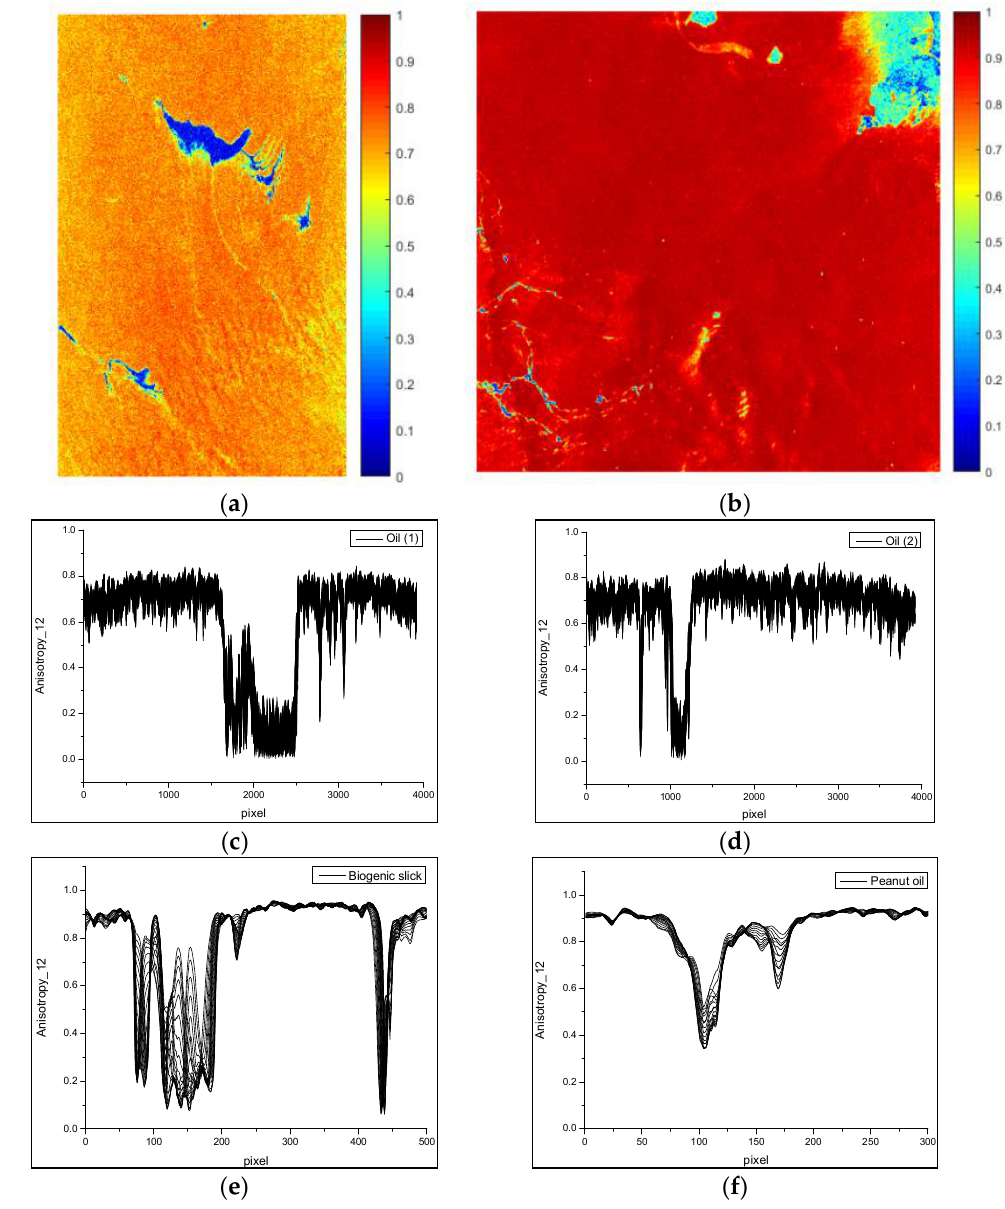
Figure 7. Modified anisotropy ( A 12 ) value for the two continuously slow-release slicks cases mentioned above: ( a ) Case 1; ( b ) Case 2; ( c – f ) the modified anisotropy for the four green rectangular areas (oil (1), oil (2), biogenic slick, and peanut oil, respectively) that are indicated on the SAR images in Figures 2 and 3.